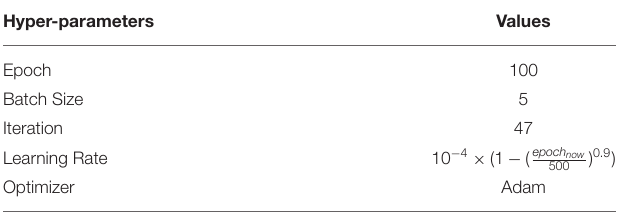
TABLE 3 | Confusion